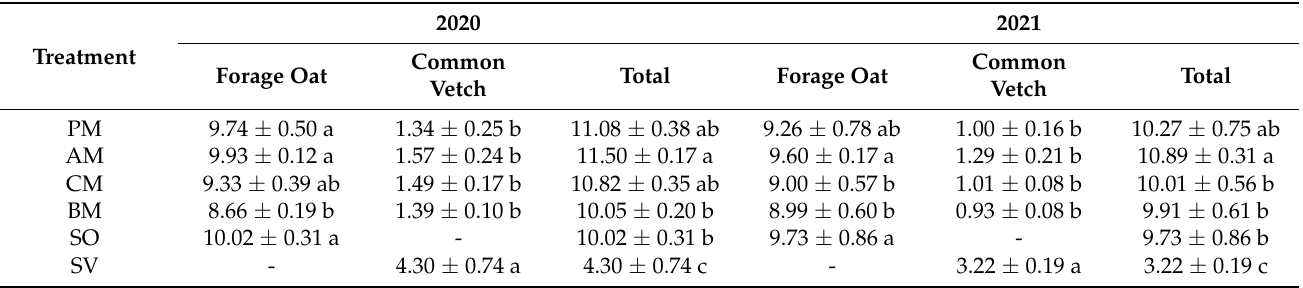
Table 5. Dry matter yield (t ha − 1 ) of forage oat and common vetch among different cropping systems over two years in Yanchi county, Ningxia, China.